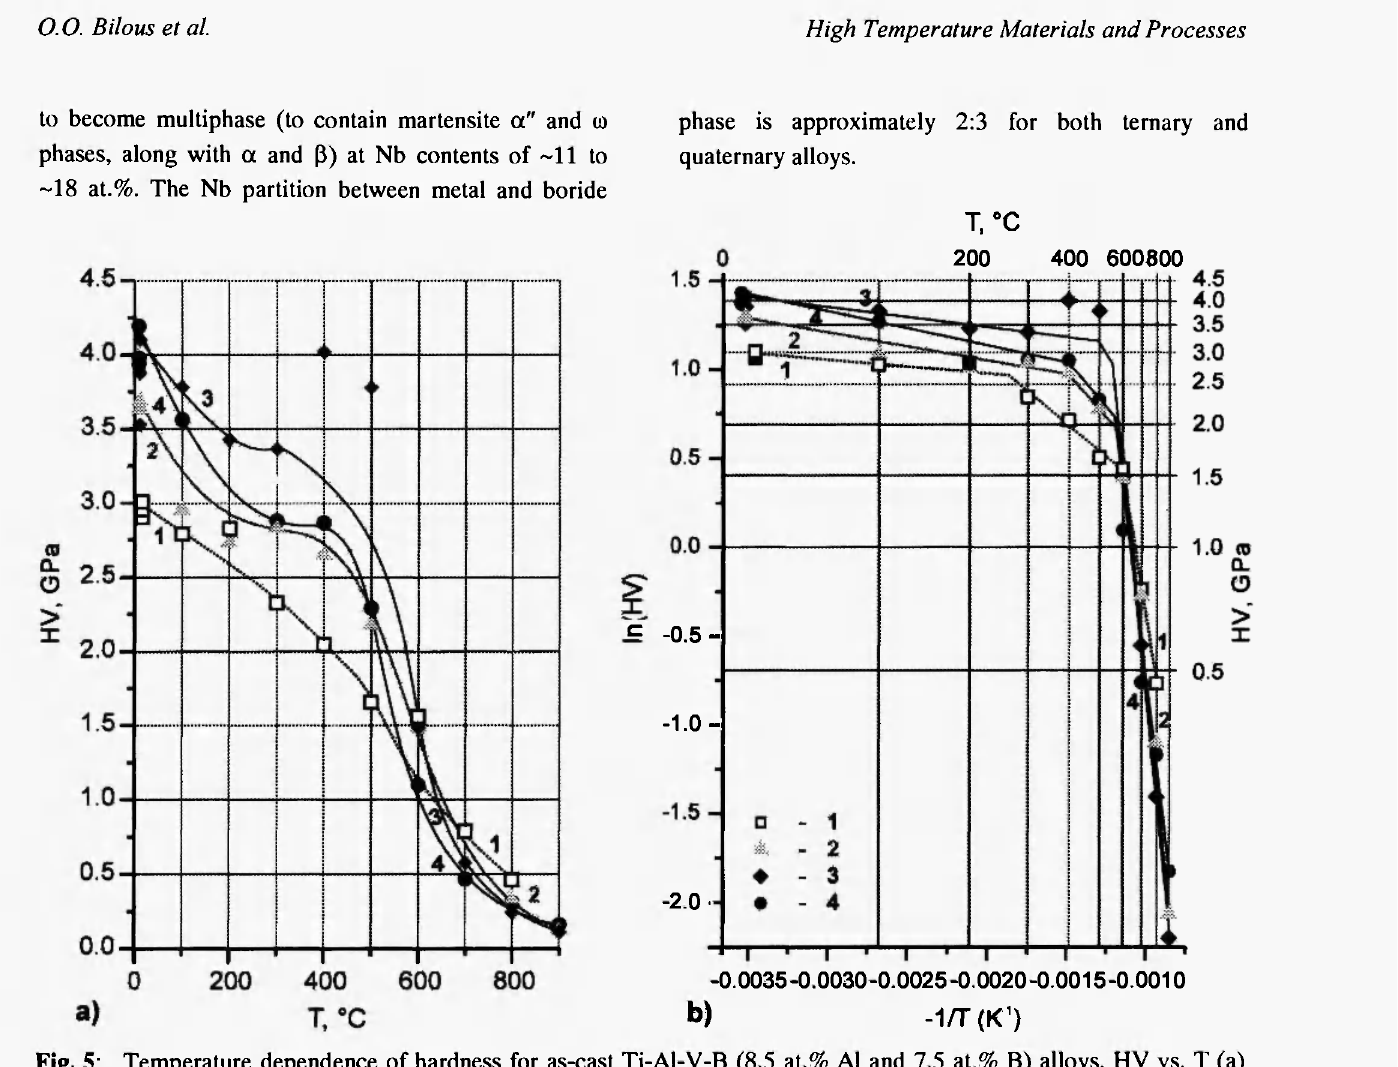
Fig. 5: Temperature dependence of hardness for as-cast Ti-Al-V -B (8.5 at.% Al and 7.5 at.% B) alloys, HV vs. Τ (a) and ln(HV) vs. -1/Γ (b). 1, TWoAl^B?.,; 2, Ti sr , 4 A] 8 .,V, h B 7 ,;